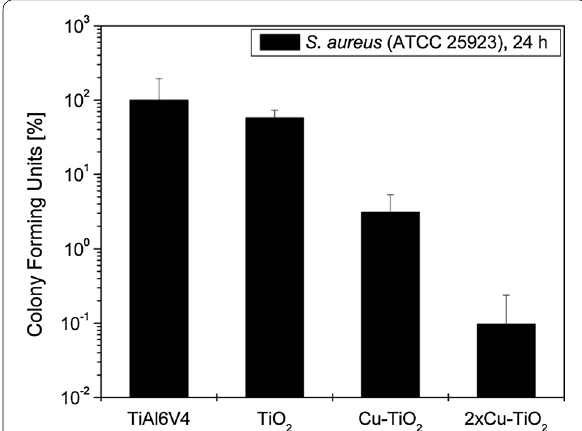
Fig. 6 Growth of S. aureus ATCC 25923 on uncoated and the different TiO 2 -coated Ti6Al4V